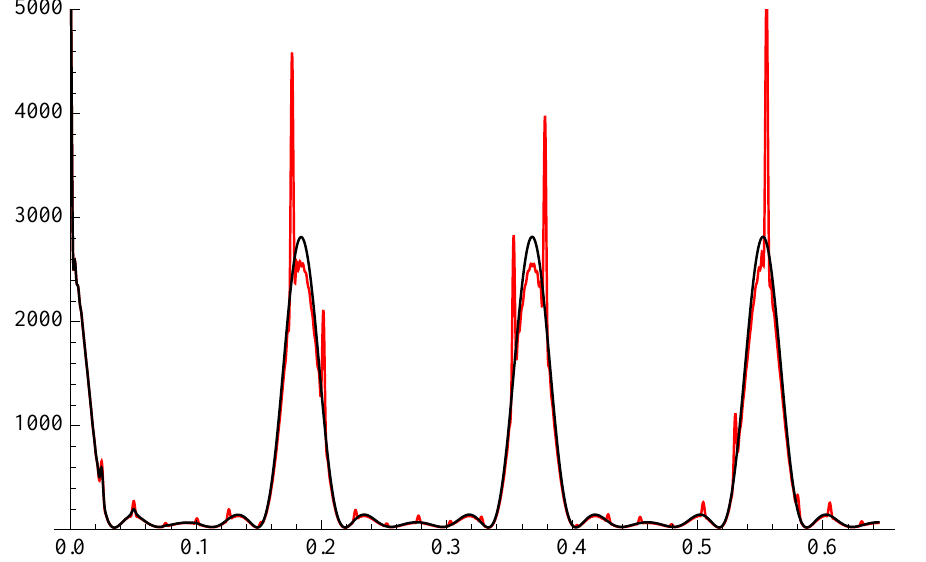
(cid:16) (cid:17) (cid:104) s a (cid:105) ± V 1/2 s ; each bunch consists of a number of planes a . N a